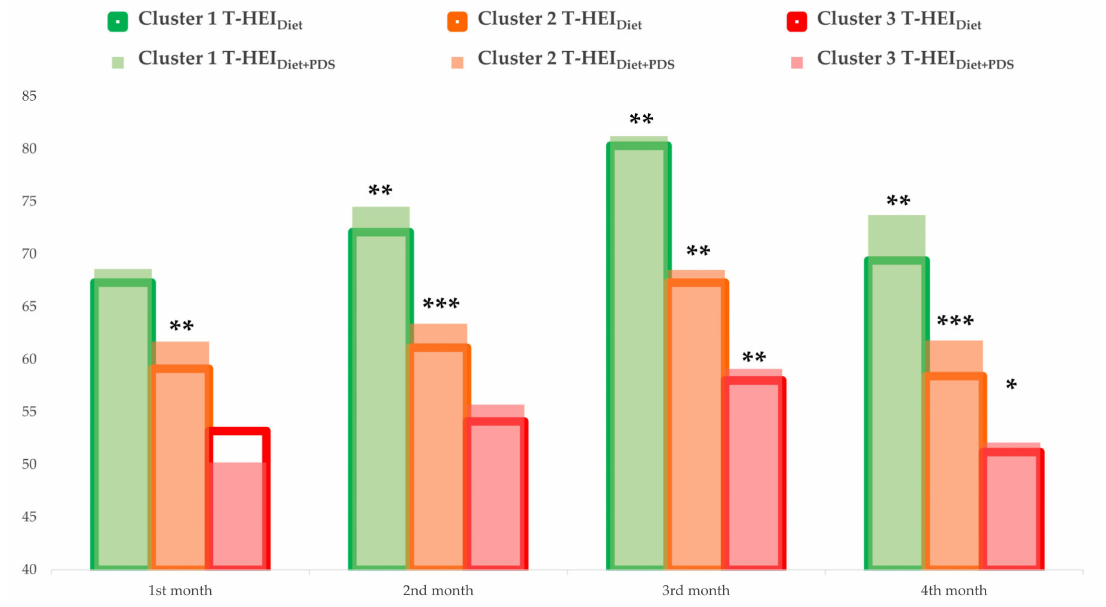
Figure 2. Bar chart for T-HEI mean changes during the intervention period. *, **, *** Indicated significant different from diet alone, compared by Wilcoxon Signed Rank test; * p <0.05, ** p <0.01, *** p <0.001. T-HEI, Taiwanese Healthy Eating Index. Table 2 shows the baseline characteristics of the full samples and the comparison between clusters. The mean age of the total participants was 80.7 ± 1.1 years with the majority of them being female (44 cases, 74.6%). It was revealed that clusters were signifi- cantly different in age [ H (2) = 8.352, p = 0.015], as well as CST [ H (2) = 6.242, p = 0.044], GS [ H (2) = 7.761, p = 0.021], and HGS performance [ H (2) = 6.702, p = 0.035]. Cluster 3 was significantly older ( z = − 18.310, p adjusted = 0.013), lower in CST ( z = 14.567, p adjusted = 0.050) and GS ( z = 15.839, p adjusted = 0.041) performance than cluster 1. Cluster 2 was significantly higher in GS ( z = 12.865, p adjusted = 0.047) and HGS ( z = 13.715, p adjusted = 0.029) performance than cluster